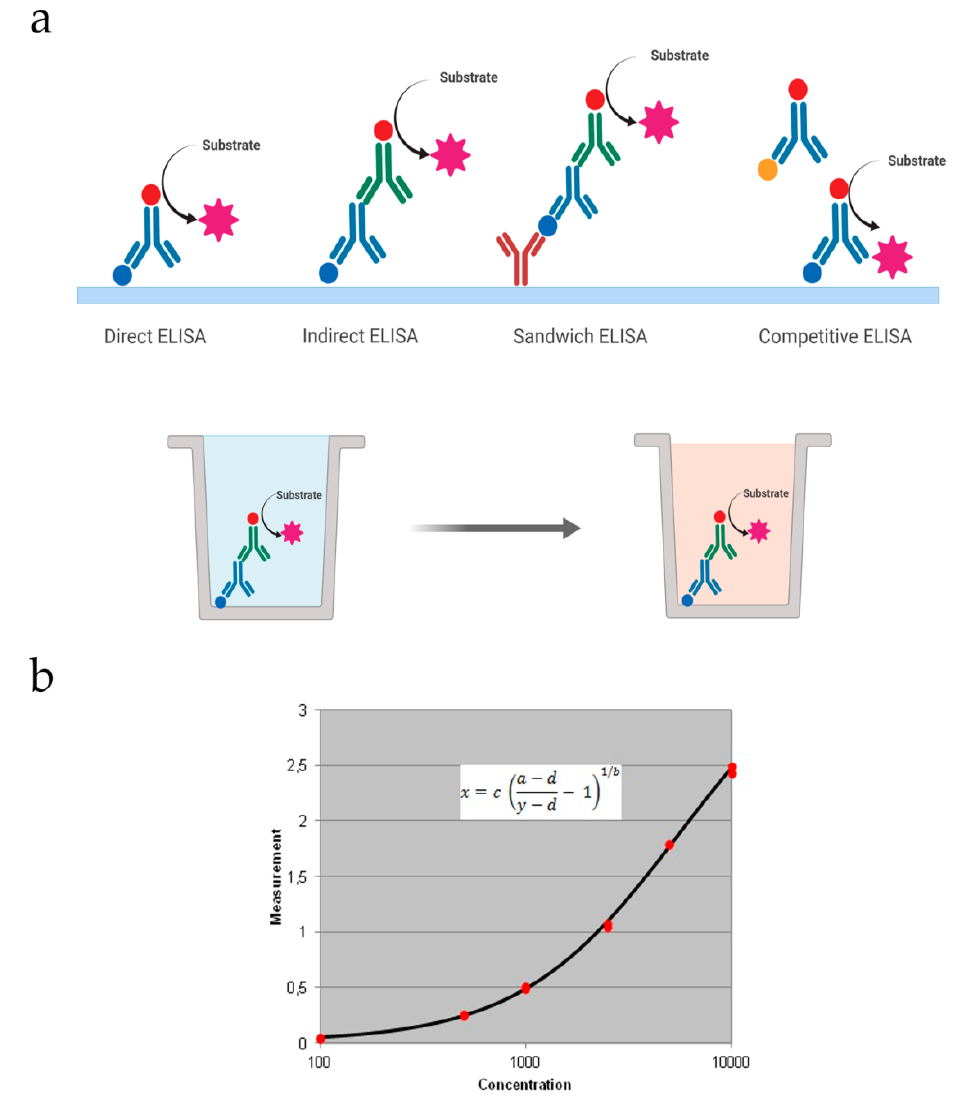
Figure 1. ( a ) Schematic representation of the various types of ELISA that can be performed on a plate; ( b ) an example of a standard curve employed to quantify the concentration of an analyte in the ELISA assay, in this case using a four parameter logistic